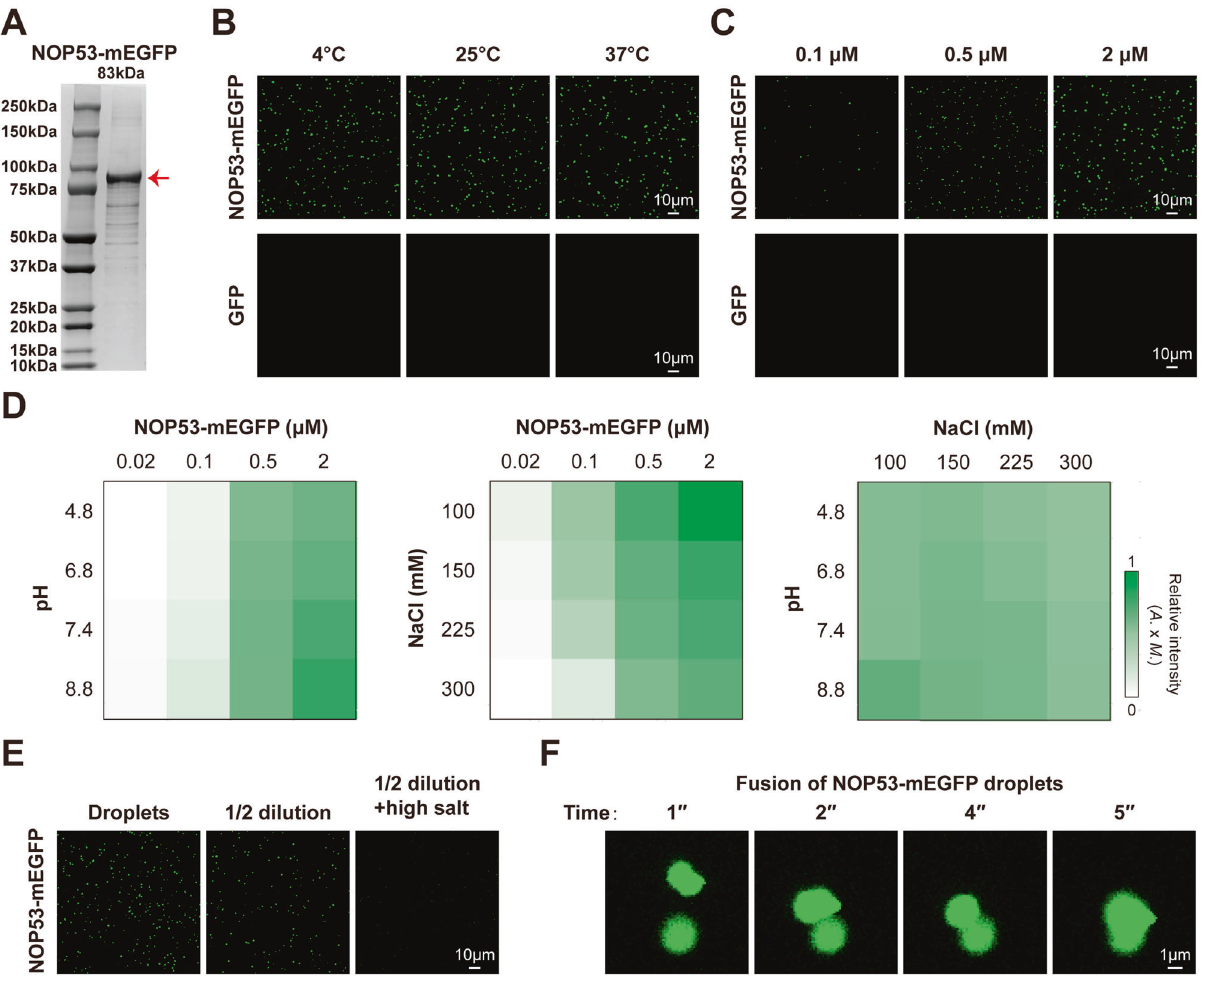
Fig. 2 Recombinant NOP53-mEGFP undergoes LLPS in vitro. A Coomassie staining of puri fi ed NOP53-mEGFP protein. B NOP53-mEGFP protein formed droplets at different temperature. Two micromolar protein was used. C NOP53-mEGFP droplets that formed in buffers containing 150 mM NaCl and 25 mM Tris-HCl (pH 7.4) were observed with confocal microscopy. D The impact of protein concentration, NaCl concentration and pH on the formation of NOP53-mEGFP droplets. The fl uorescence intensity of droplets is presented as the mean intensity × area. E NOP53-mEGFP droplets were disrupted by dilution and increasing NaCl concentrations. Droplets formed in buffer containing 2 μ M NOP53-mEGFP and 150 mM NaCl at pH 7.4; high salt, 500 mM NaCl. F Two in vitro-formed NOP53-mEGFP droplets fused to form a larger